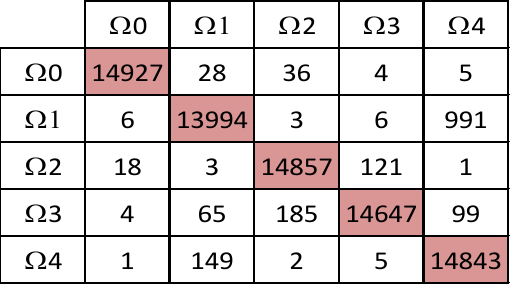
Figure 10. Confusion matrix of GAU_1.0 and MF3 operator sequence.